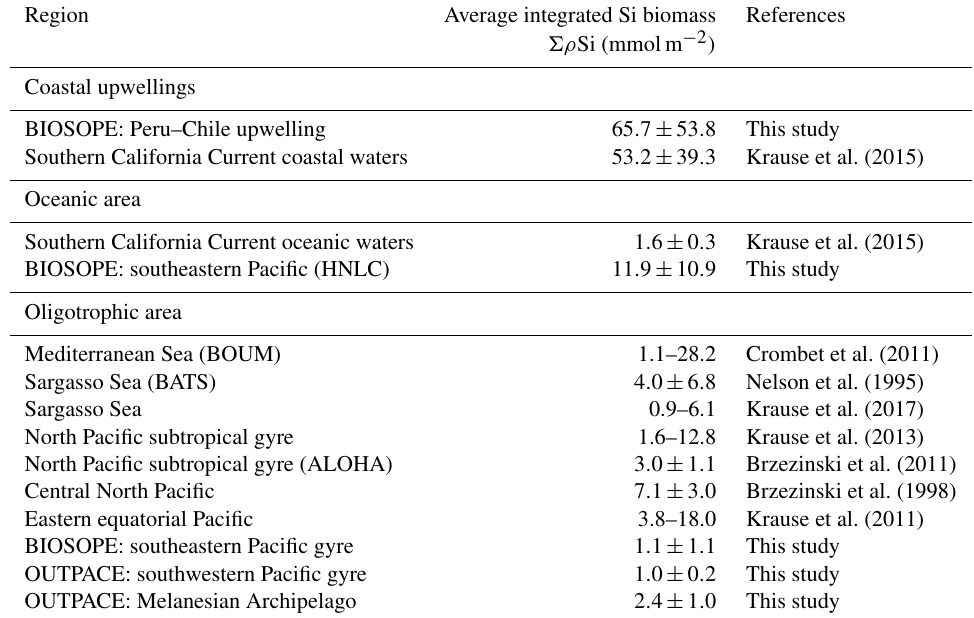
Table 5. Summary of (cid:54) BSi stocks (in mmolSim − 2 ) for the OUTPACE and BIOSOPE and other oceanic and oligotrophic systems.